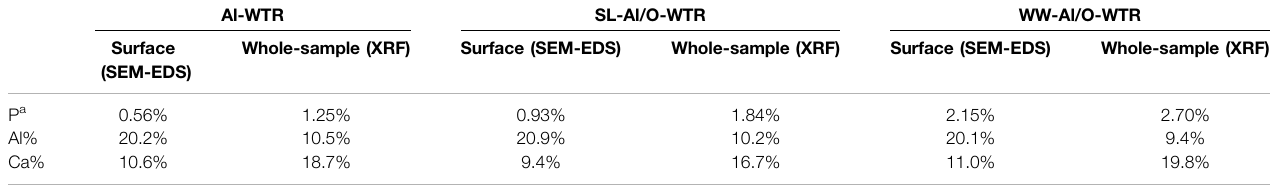
TABLE 2 | P, Al and Ca oxide proportions on surfaces and in whole samples of Al-WTR, SL-Al/O-WTR and WW-Al/O-WTR. Modi fi ed from (Zohar et al.,